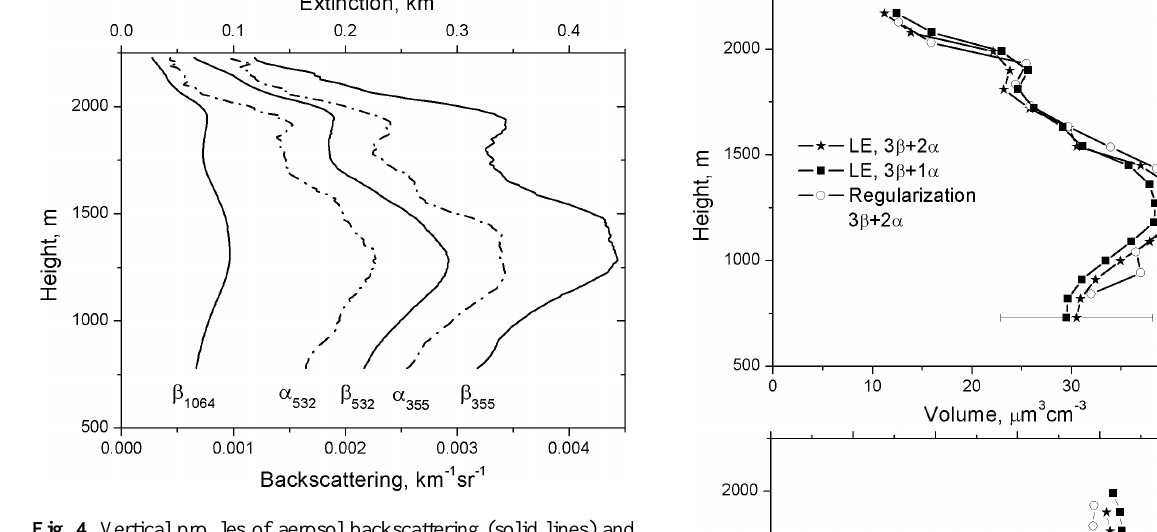
Fig. 4. Vertical profiles of aerosol backscattering (solid lines) and extinction (dashed lines) coefficients measured at 355, 532 and 1064 nm wavelengths on 15 August 2006.